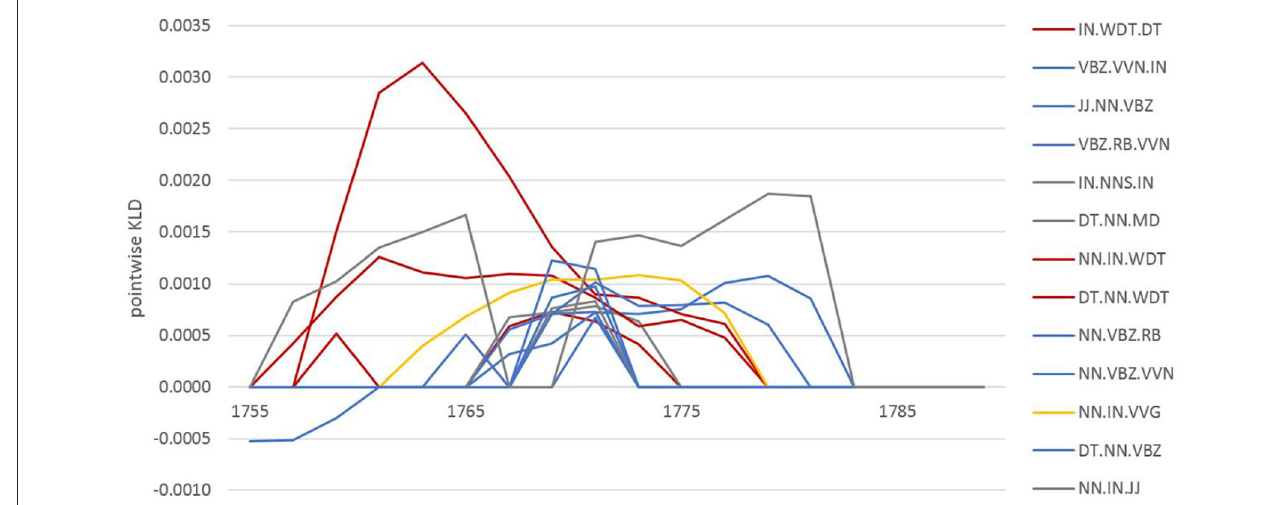
FIGURE 4 | Pointwise relative entropy based on POS trigrams for the PAST model in 1771.